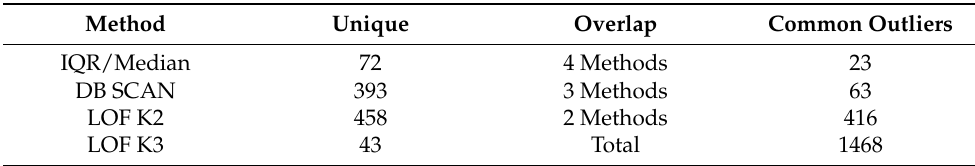
Table 2. Methods